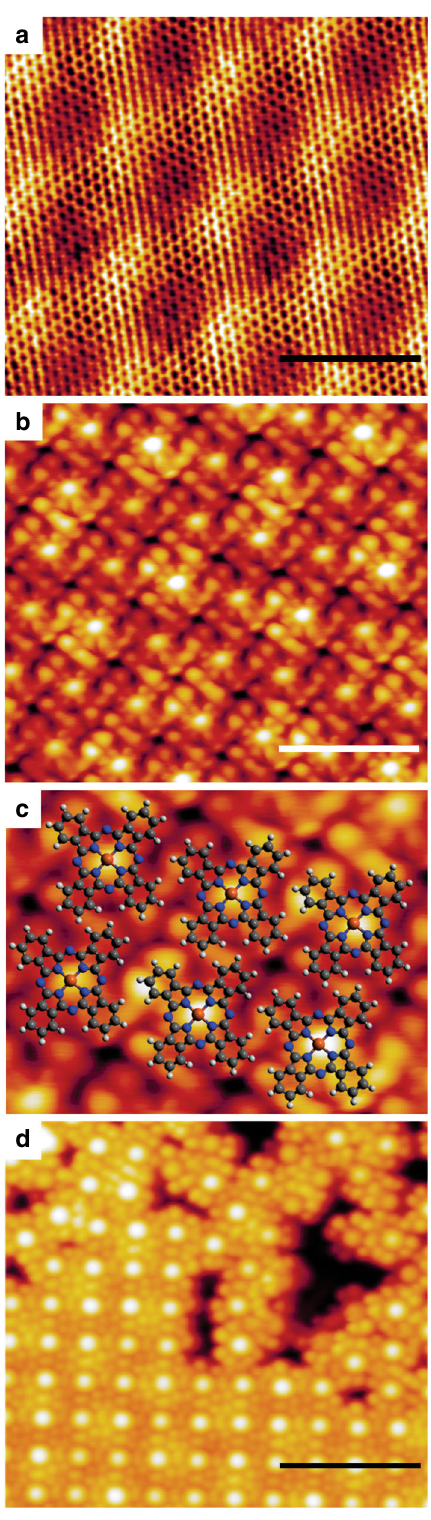
Fig. 1 Structural characterization of the FePc/GR system. a STM image of bare graphene on Ir(111). b STM image of the FePc single, well-ordered layer on graphene and c the structural model of the molecules. d A boundary between ordered and disordered domains. All images were taken under UHV conditions at 4 K [ a V bias = + 0.1 V, I = 1 nA; b, c V bias = − 2.0 V, I = 0.2 nA; d V bias = − 2.0 V, I = 0.1 nA; error bars: a , b 3